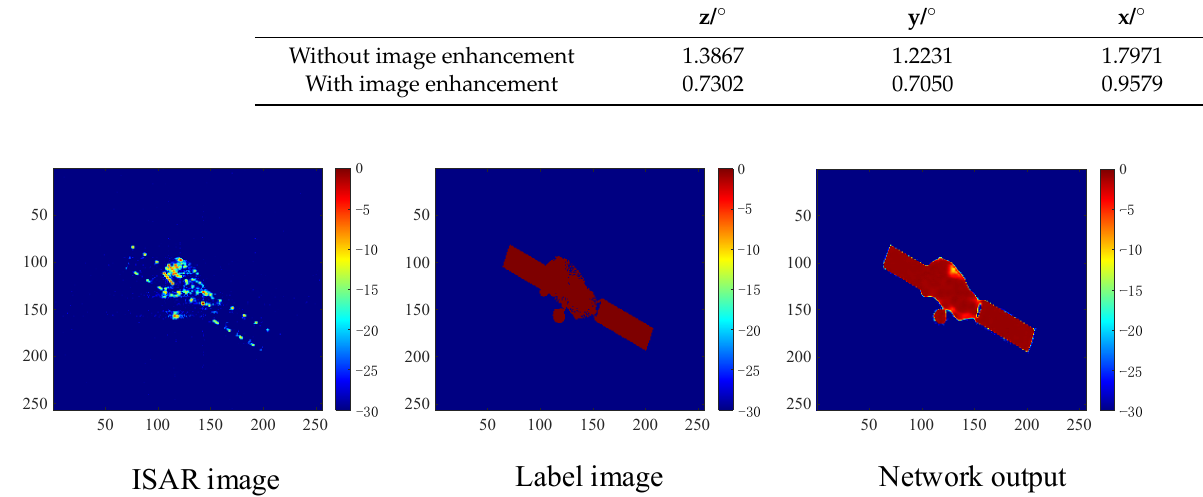
Figure 10. The imaging results of test data 1. Table 5. The attitude estimation results of test data 1.